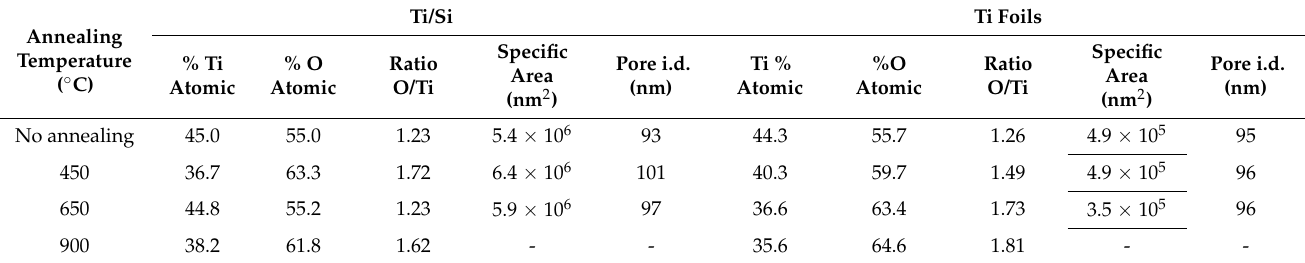
Table 1. Chemical composition of TiO 2 samples before and after annealing (EDX